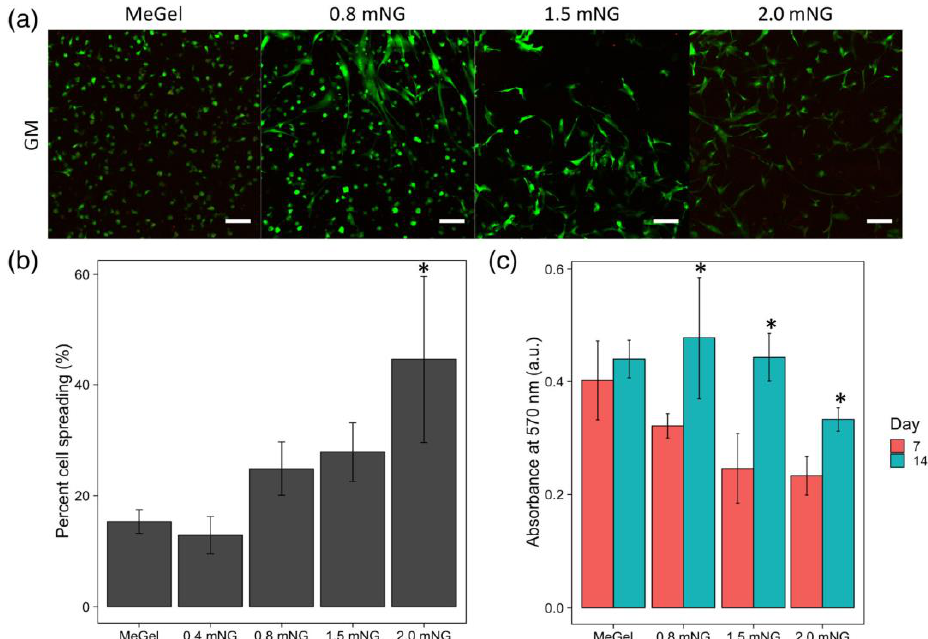
Figure 13. Biocompatibility of Me-Gel and mNG hydrogels. ( a ) Representative images of live/dead staining of cells encapsulated within the different hydrogels (scale bar = 100 μm). ( b ) Percent cell spreading in hydrogels. ( c ) Cell metabolism over time. * p < 0.05. Reprinted with permission from ref. [178]. Copyright 2021, Wiley Periodicals.